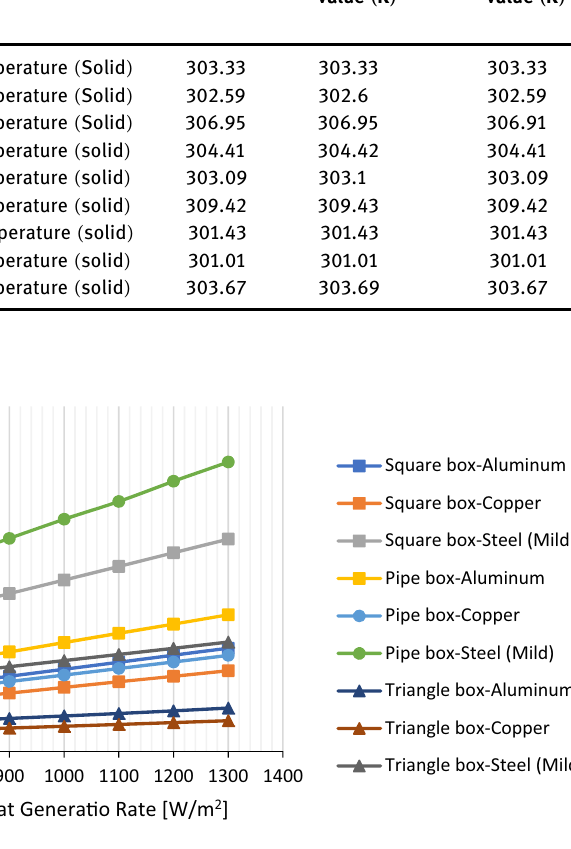
Figure 8: Collector temperature vs. heat generation rate.